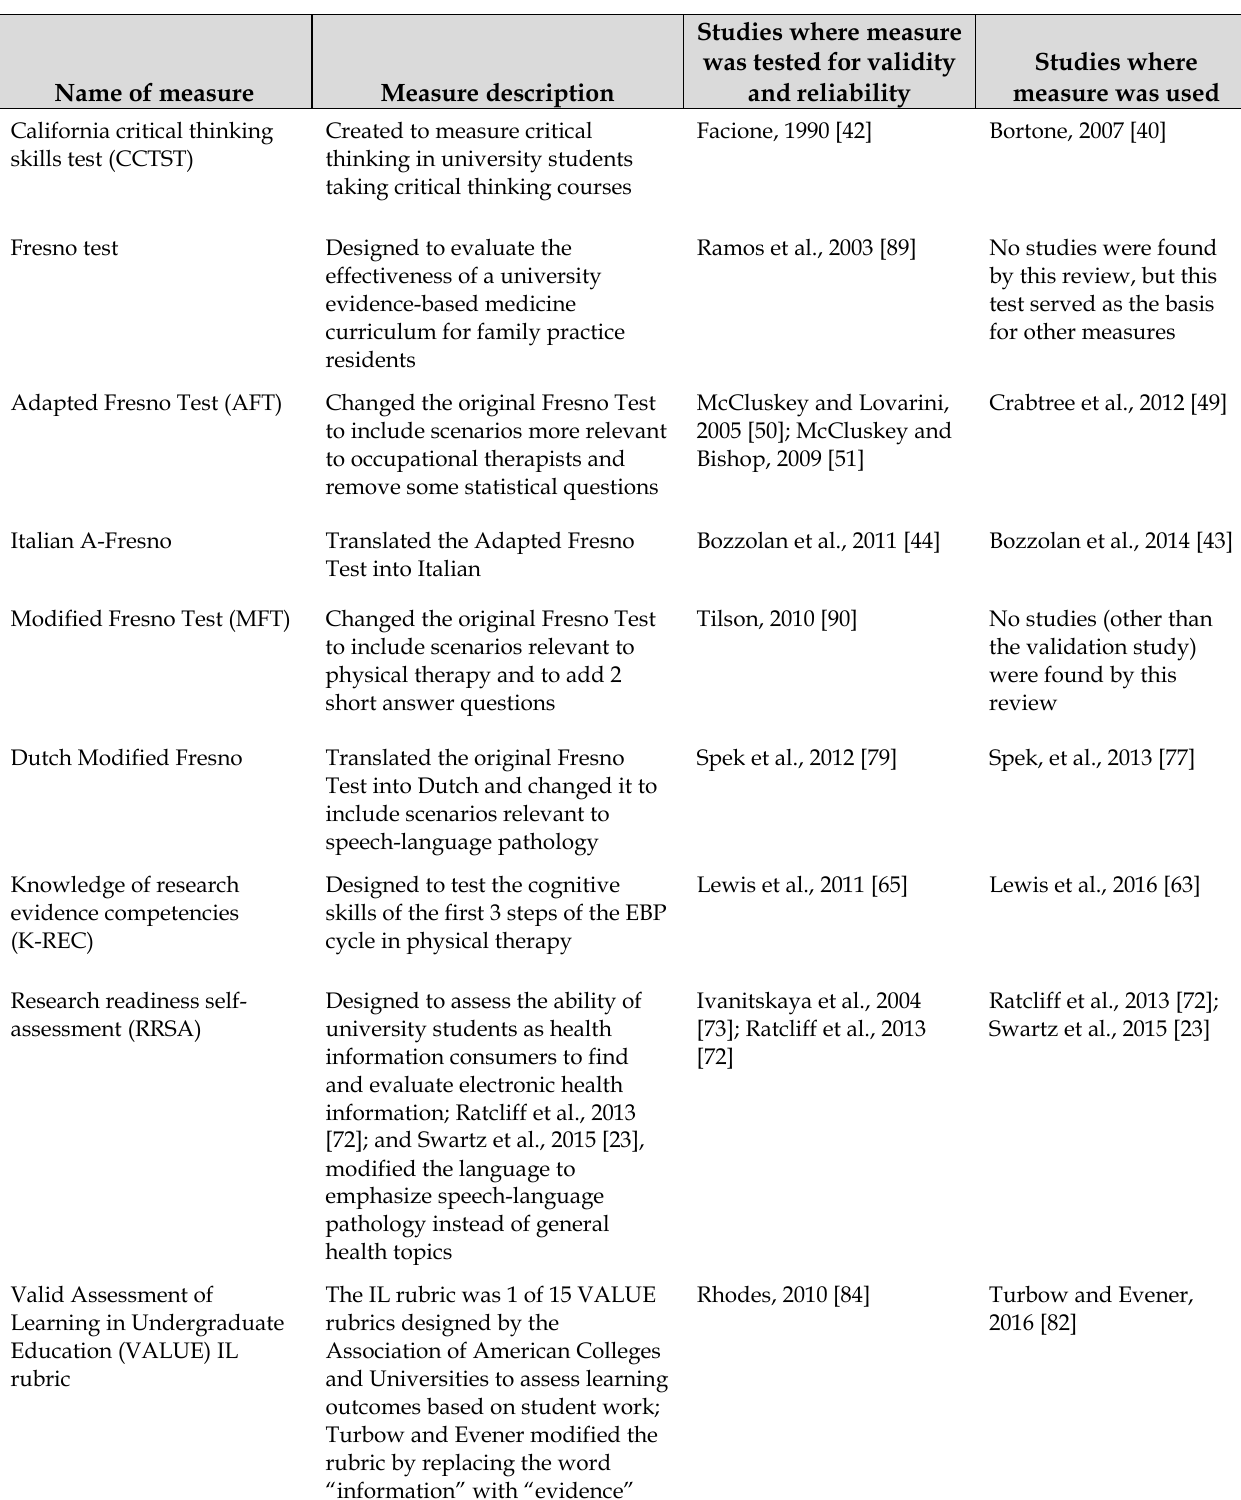
Table 2 Published assessment